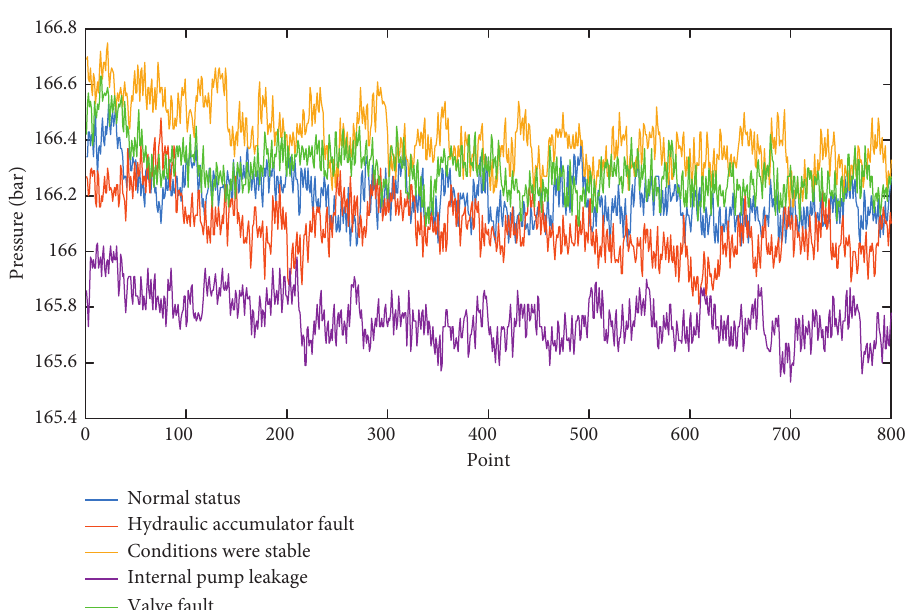
Figure 5: The pressure signal curve under five different fault conditions collected by the hydraulic